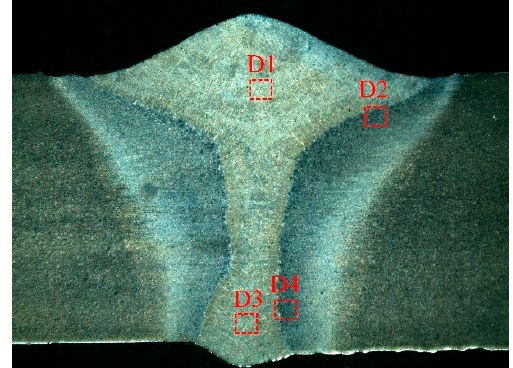
Figure 16. Location of microstructure selection.